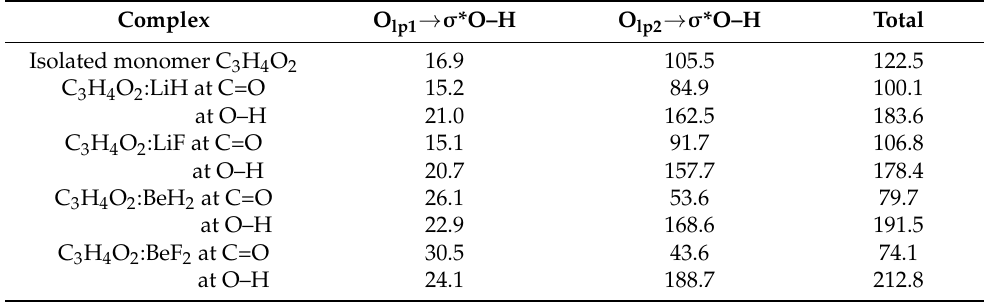
Table 2. Intramolecular charge-transfer stabilization energies (kJ · mol − 1 ) for complexes of C 3 H 4 O 2 with